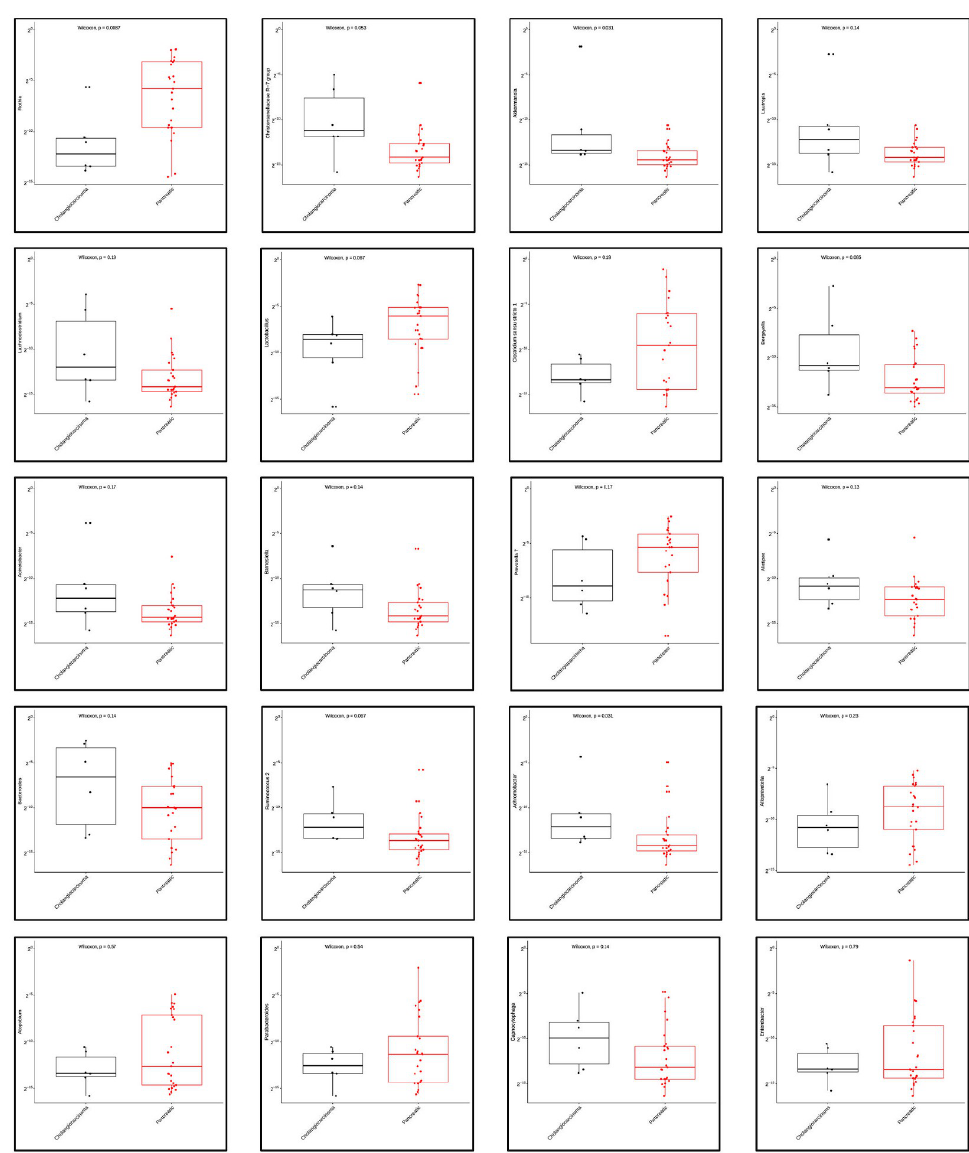
Fig 8. Mann Whitney-U test showing differential abundance of bacterial genera in bile from patients with pancreatic cancer vs cholangiocarcinoma.